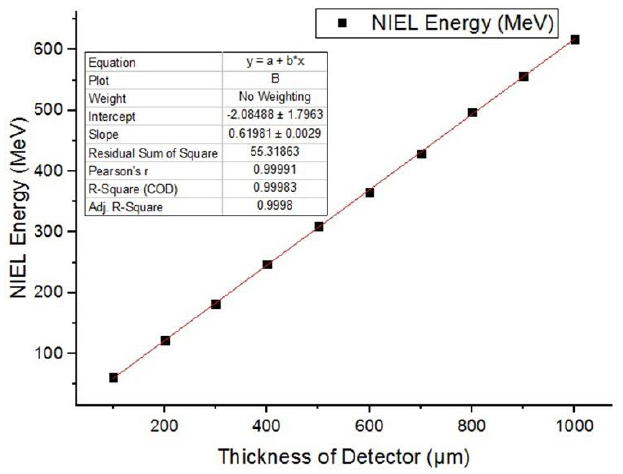
Figure 12. Relationship between nonionizing energy deposition (NIEL) produced by neutrons and the thickness of SDD.